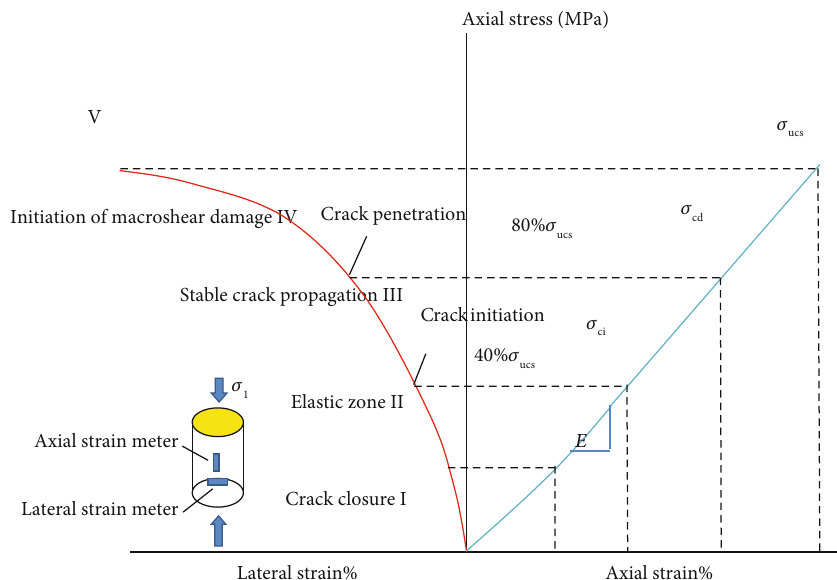
Figure 1: Typical stress-strain curves of rock under uniaxial compression.